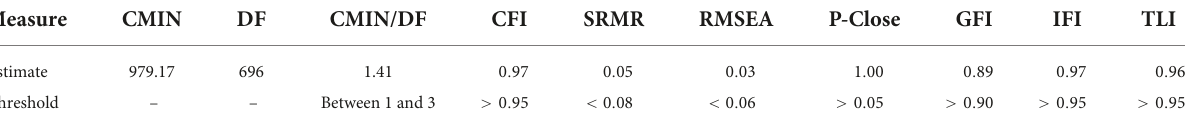
TABLE 1B Confirmatory factor analysis. Measure